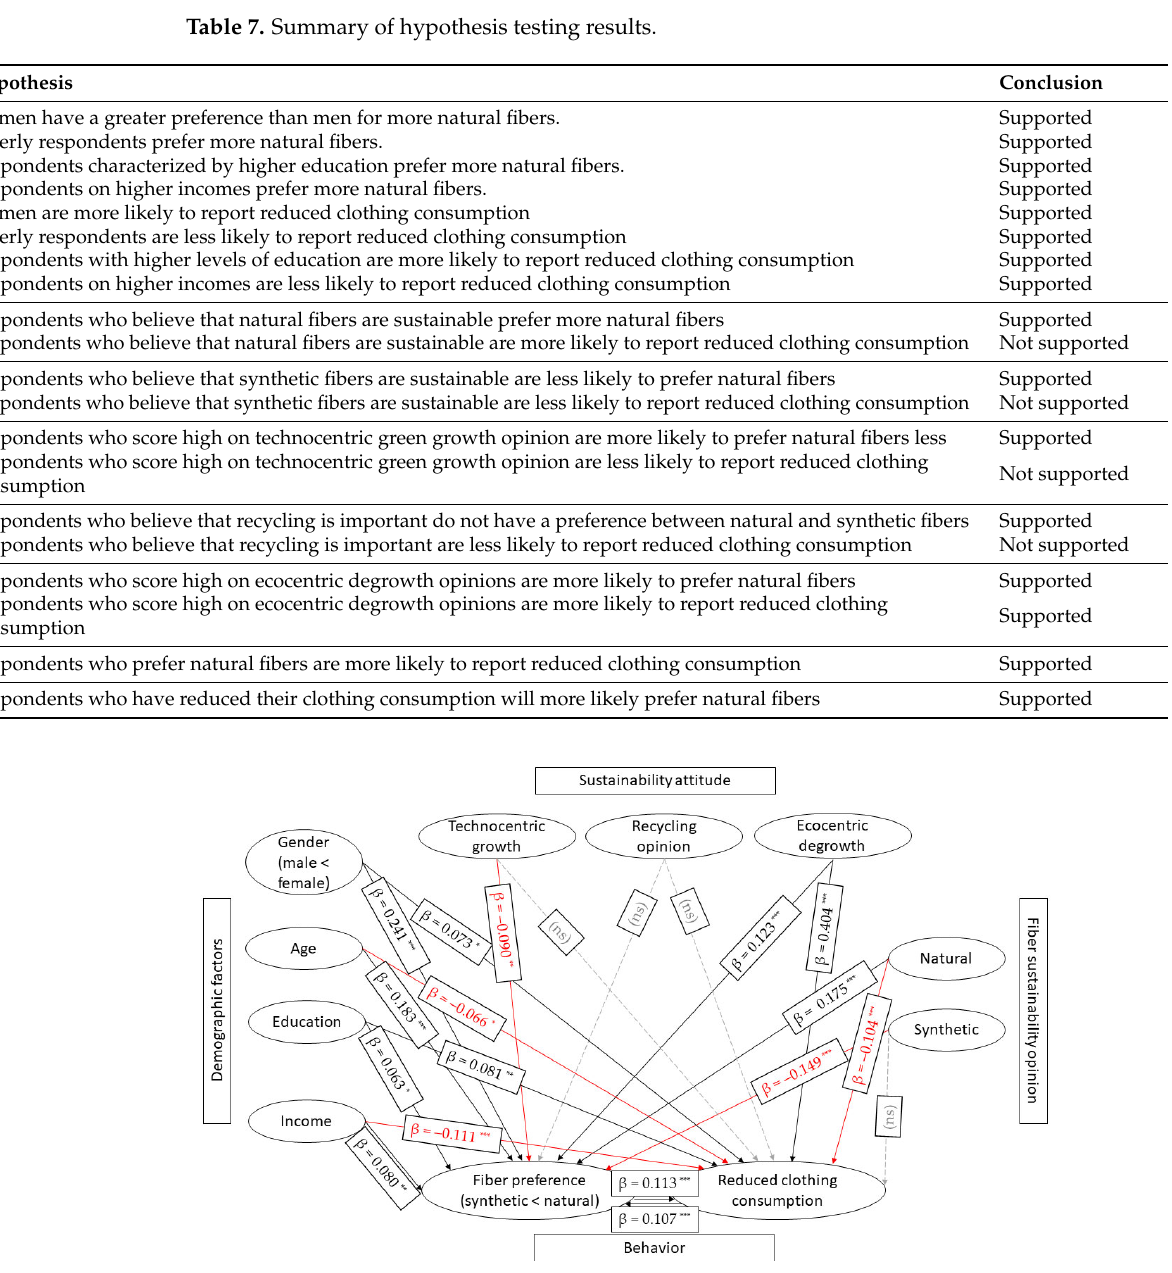
Figure 2. Results of regression models with standardized beta coefficients and significance (* p < 0.05; ** p < 0.01; *** p < 0.001, ns = not significant p ≥